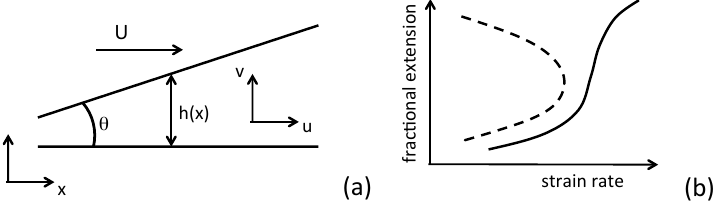
Figure 2. ( a ) Schematic of the liquid wedge near the contact line and ( b ) schematic of supercritical coil-stretch transition